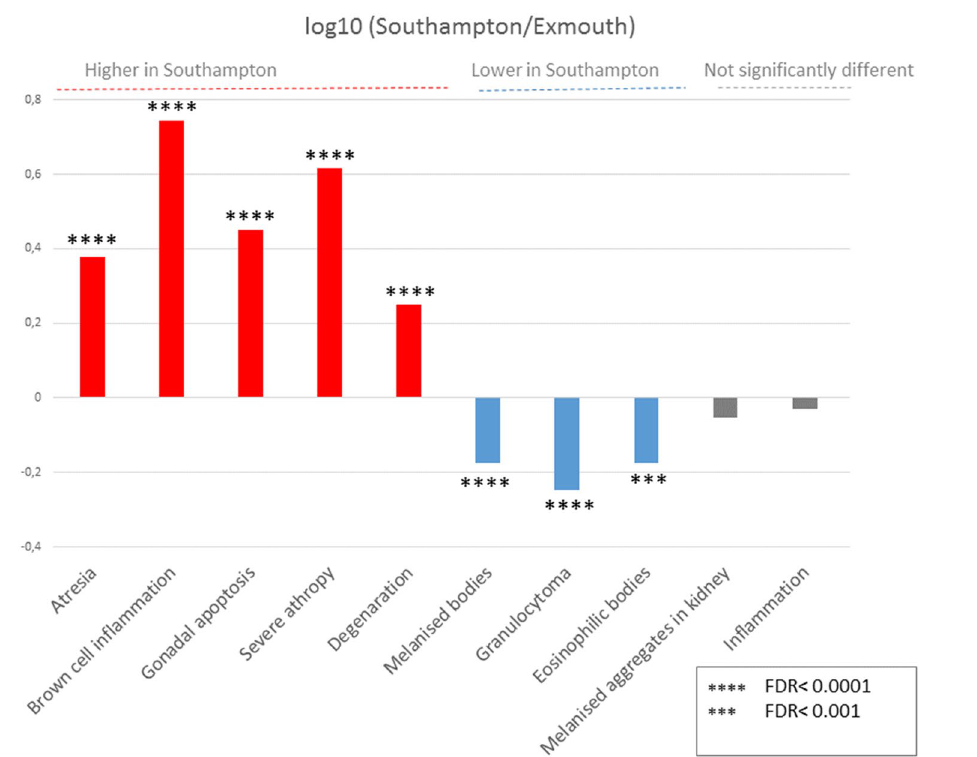
Figure 6. Ratio of histological parameters in Southampton and Exmouth mussels, based on re-analysed data from Bignell et al . 2008.